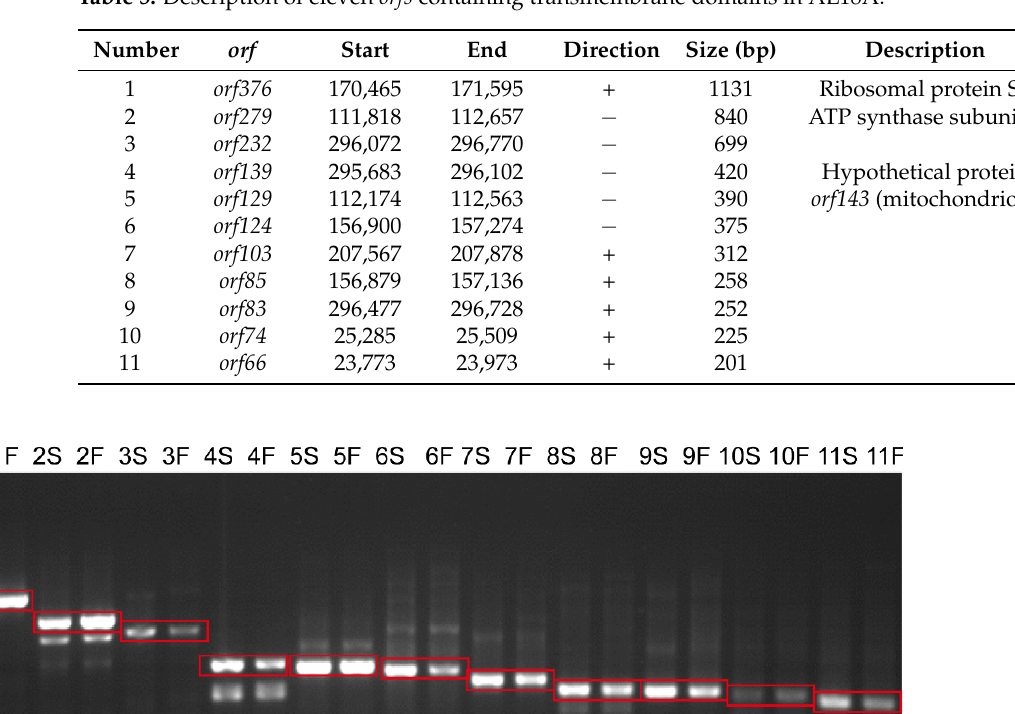
Figure 4. Venn diagram showing the mutual overlaps of orfs in the AL18B and AL18A. Table 5. Description of eleven orfs containing transmembrane domains in AL18A.